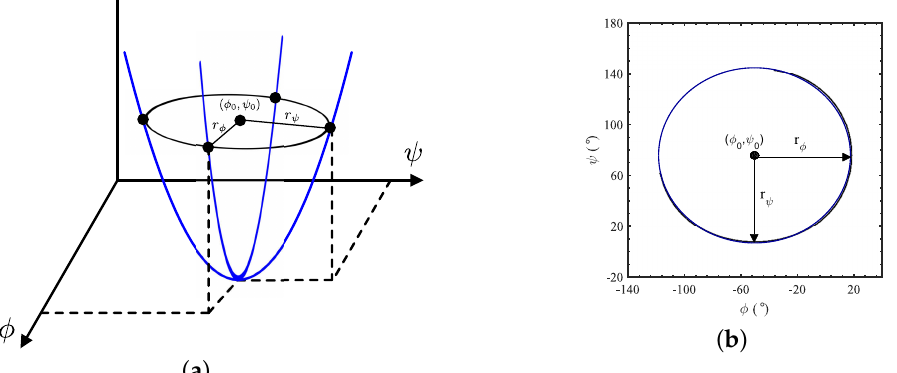
Figure 12. ( a ) Illustrative double parabolic estimation representation of the ellipsoidal model, and ( b ) the result of applying the model to the filter with Ω Ek (blue trace) superimposed to the result of the phase map (black